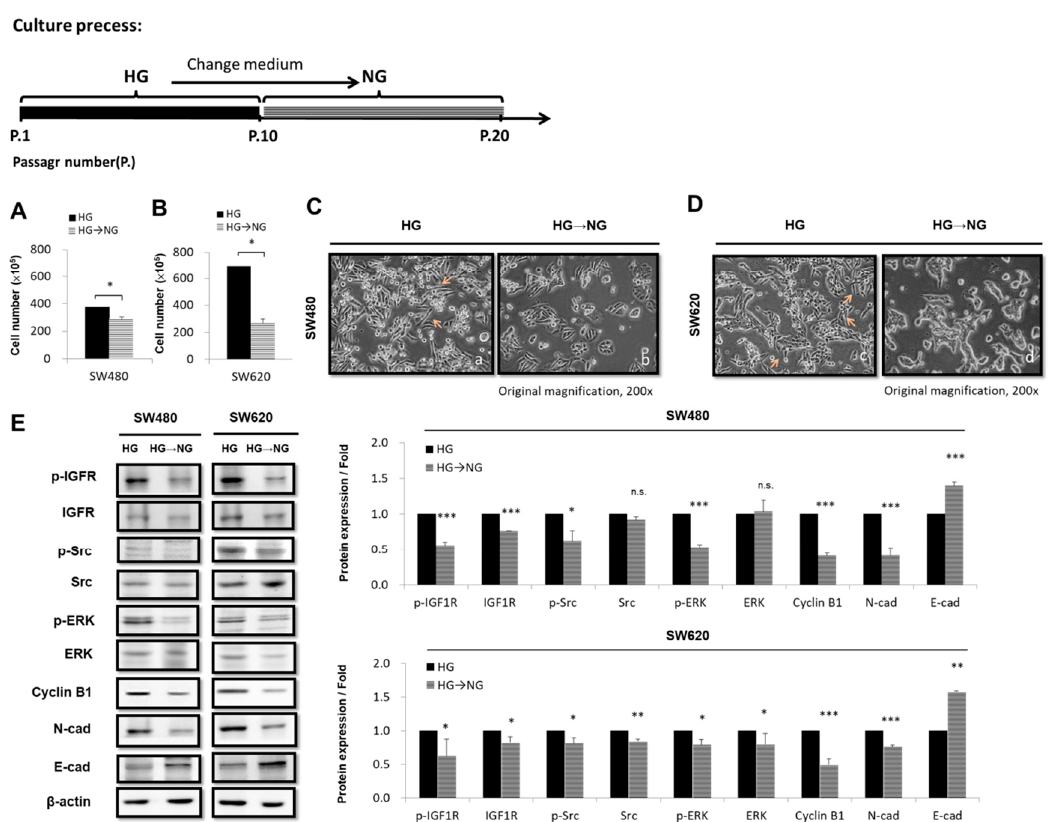
Figure 5. Expression of cell proliferation and morphology was reversible in colorectal cancer (CRC) cell lines by transferring them from high glucose (HG)-concentration medium to normal glucose (NG)-concentration medium. ( A ) SW480 and ( B ) SW620 cells were exposed to medium with different concentrations of glucose, namely NG (5.5 mM D -glucose) and HG (25 mM D -glucose), for a period from 0 to 120 h. Trypan blue stain assay was used to analyze proliferation rates. After 10 generations, a significant rescue of proliferation rate was observed in CRC cells cultured in NG- and HG-concentration media for 120 h compared with the control group. ( C – E ) Transferring cells from HG- to NG-concentration medium rescued epithelial-to-mesenchymal transition (EMT) protein marker expression and cell-cycle-regulated protein reversed EMT protein marker expression; cell-cycle-regulated protein reduced cell proliferation and changed cell morphology to an epithelial type. Levels of β -actin were evaluated as loading controls. These data show that the cellular mechanism modulated by glucose concentration in CRC lines is reversible. Statistically significant differences between the two groups were judged by Student’s t -tests; * p < 0.05, ** p < 0.005, *** p < 0.001; n.s. = nonsignificant.